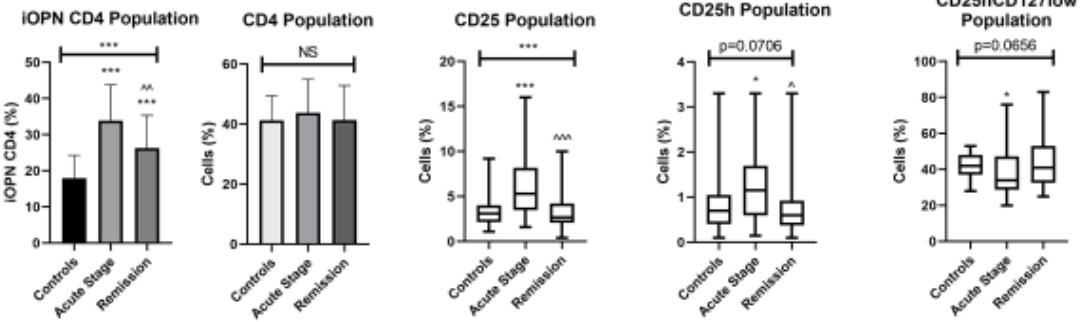
Figure 1. The examined populations of CD4 T lymphocytes in the patients with ACD and healthy controls. iOPN CD4, CD4 T lymphocytes with expression of intracellular osteopontin; CD4, CD4 positive T lymphocytes; CD25, subset of CD4 positive T lymphocytes; CD25h, T lymphocytes with high CD25 expression; CD25hCD127low, T lymphocytes with high CD25 expression and CD127 low expression—regulatory T cells; NS, non-significant; * means statistical significance with p values < 0.05 between patients with acute stage of ACD and controls; *** means statistical significance with p < 0.0001 between patients with acute stage of ACD and controls; ^—statistical significance with p values < 0.05 between patients with acute stage of ACD and remission; ^^/^^^—statistical significance with p values < 0.01 and 0.0001, respectively, between patients with acute stage of ACD and remission.